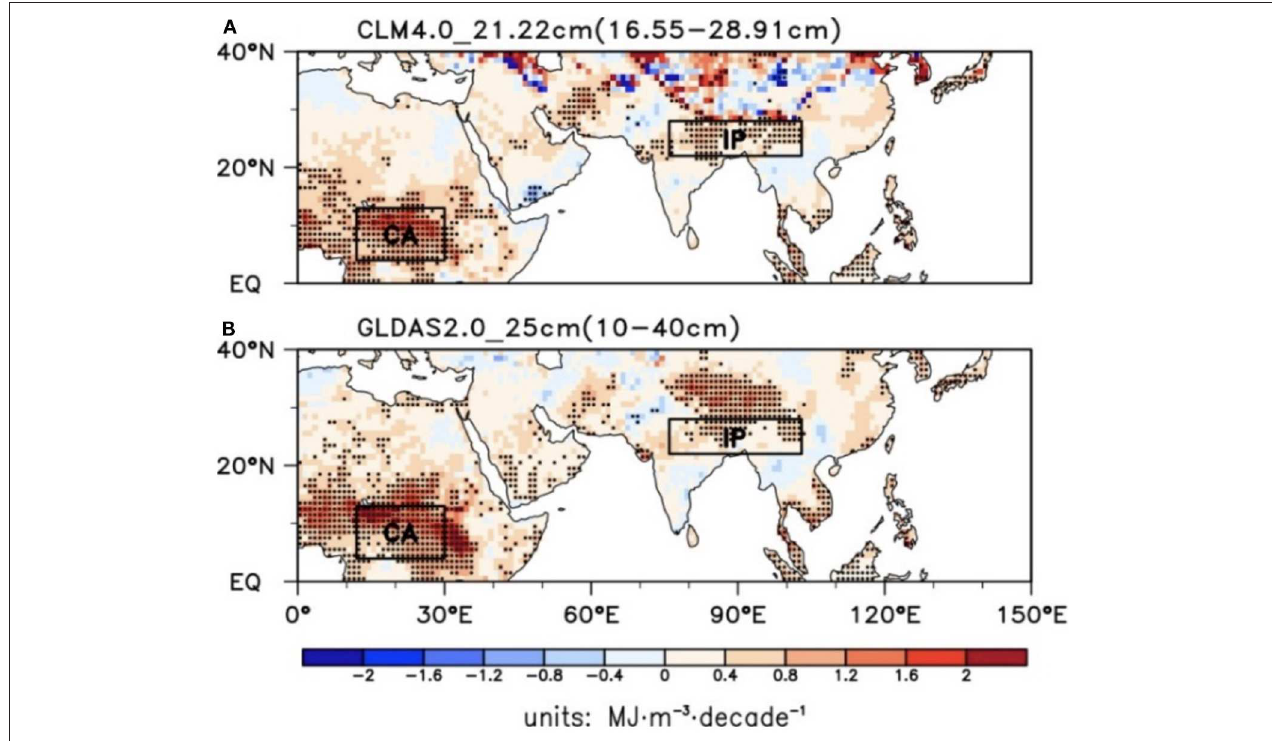
FIGURE 10 | Spatial distribution of linear trend of winter soil enthalpy at mid-low latitudes from 1979 to 2010 ( A CLM4.0, B GLDAS2.0), and dotted area is significant ( p < 0.05).